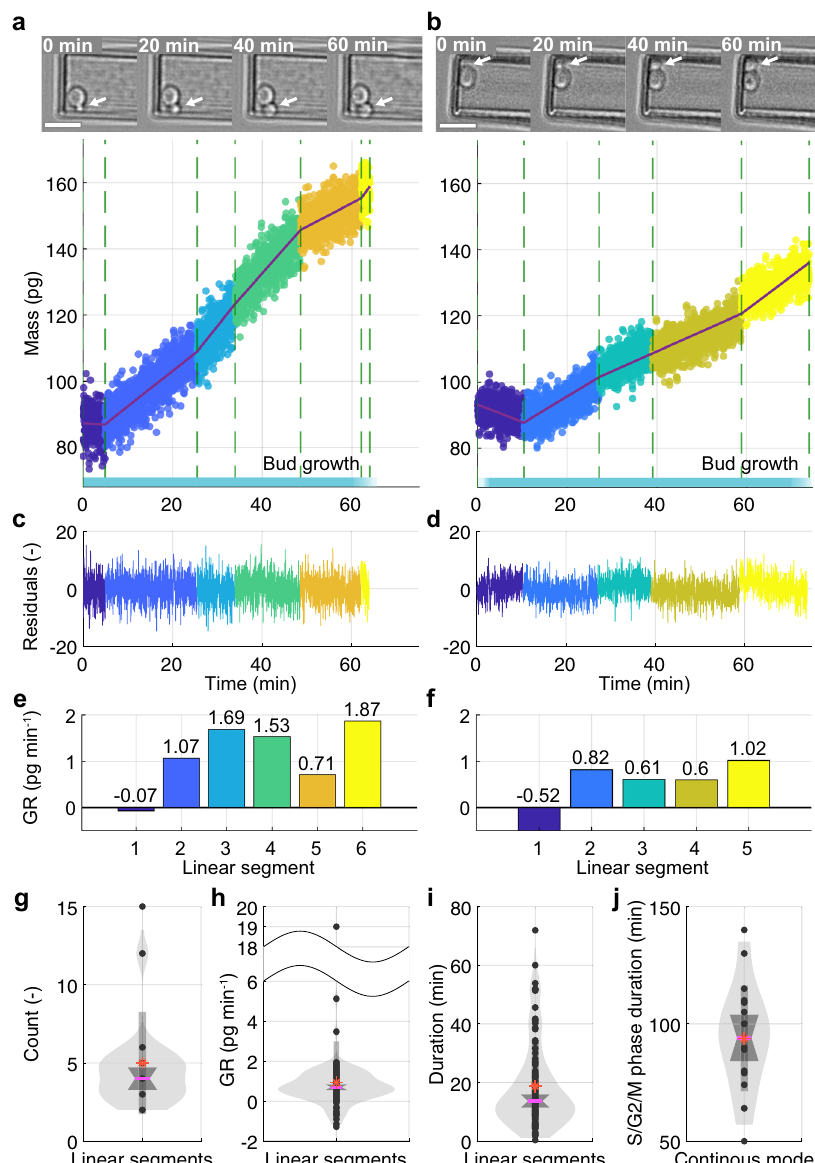
Fig. 4 Single S. cerevisiae cells budding daughter cells increase mass in linear segments. a , b Mass versus time curves of two S. cerevisiae cells segmented (green vertical dashed lines) into phases of linear growth (colored) by a segmented linear regression model (SLM) (violet lines). DIC images show budding cells attached to the cantilever of the picobalance. Shown are raw data. Scale bars (white), 10 μ m. Mass measurements were recorded using the continuous mode. Cyan bars indicate where cells are in the S/G2/M phase when bud growth is observed. c , d Residuals of fi tting the SLM to the raw data of growth curves. e , f Growth rate (GR) of each linear growth segment (colored) shown in ( a , b ). GR values given above the bars. g – j Growth analysis of ( n = 19) biologically independent cells measured using the continuous mode in ( n = 19) independent experiments. Data represented with violin plots show the raw data (gray dots), mean (orange star), median (pink line), mean and standard deviation (mean ± SD, medium gray vertical box), distribution as kernel density (light gray area from the 1st percentile q (0.01) to the 99th percentile q (0.99)) and the 95% con fi dence interval (CI, dark gray edges of hourglass hexagon). g Distribution of the number of linear growth segments measured for all cells. Mean is 5 (orange star) and median (horizontal pink line) is 4 segments per cell with 95% CI = [3.3, 4.7] (dark gray edges of hourglass hexagon). The distribution of the data is shown by the kernel density (light gray area) and the standard deviation (SD, medium gray vertical box). h Growth rates determined from linear growth segments of all cells. Median is 0.70 pg min – 1 with 95% CI = [0.6, 0.9]. i Duration (time span) of the linear growth segments of all cells. Median is 13.7 min with 95% CI = [11.4, 16.0]. j Duration of the budding (S/G2/M) phase of all cells. Median is 94 min with 95% CI = [84.1,